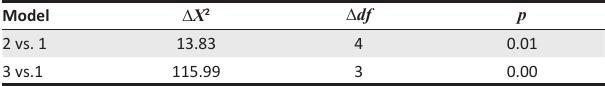
TABLE 3: Chi-square difference test for comparing nested models.